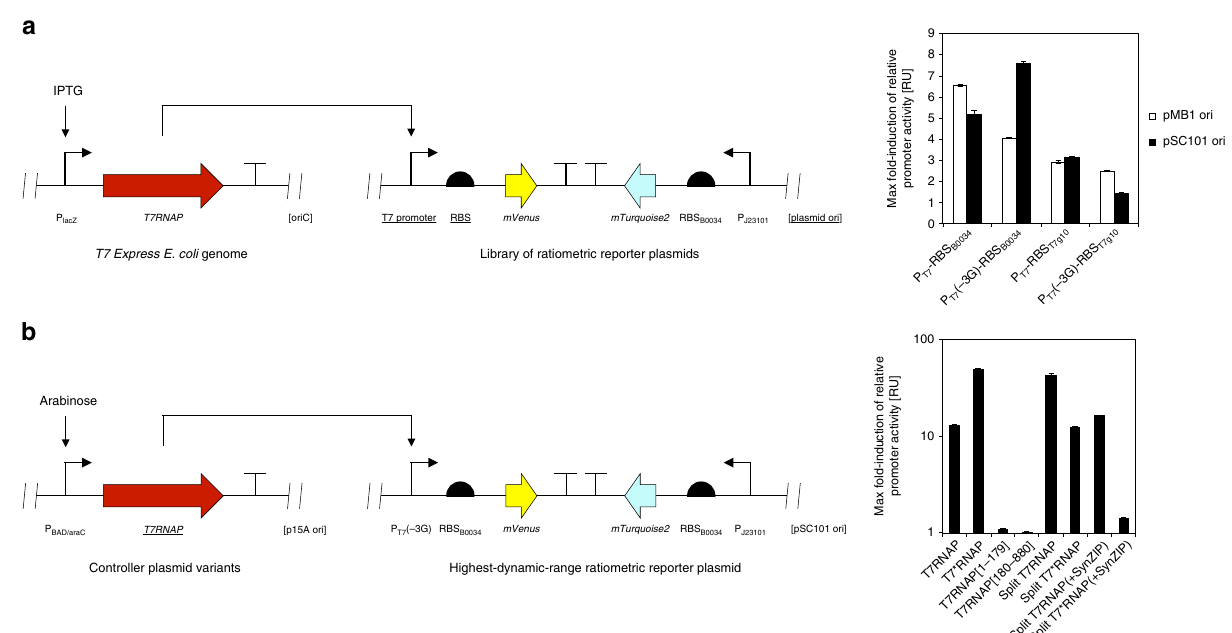
Fig. 2 Ratiometric characterization of T7RNAP activity. a Comparison of different ratiometric reporter plasmids of T7RNAP activity. Ratiometric reporter plasmids combining different variants of the T7 promoter, 5 ′ -UTRs, and origins of replication (underlined) were introduced into T7 Express E . coli . The maximum fold-induction of relative activity from the T7 promoter in response to a range of IPTG concentrations (see Supplementary Figure 1 for induction curves) was quanti fi ed using a plate fl uorometer-based assay (see Methods for details), and is reported relative to the absence of inducer. Error bars represent the standard deviation (s.d.) of average values yielded between three biological replicate experiments performed on different days. b Ratiometric characterization of intact and split variants of T7RNAP. TOP10 E . coli were co-transformed by the highest dynamic range ratiometric reporter p4g3VT tested under a and different controller plasmids encoding intact or fragmented variants of the T7RNAP gene (underlined) under control of the arabinose- inducible P BAD/araC promoter. The maximum fold-induction of relative activity from the T7 promoter in response to a range of arabinose concentrations was quanti fi ed as described above (see Supplementary Figure 2 for induction curves), and is reported relative to the absence of inducer. Error bars represent the s.d. of average values yielded between three biological replicate experiments performed on different